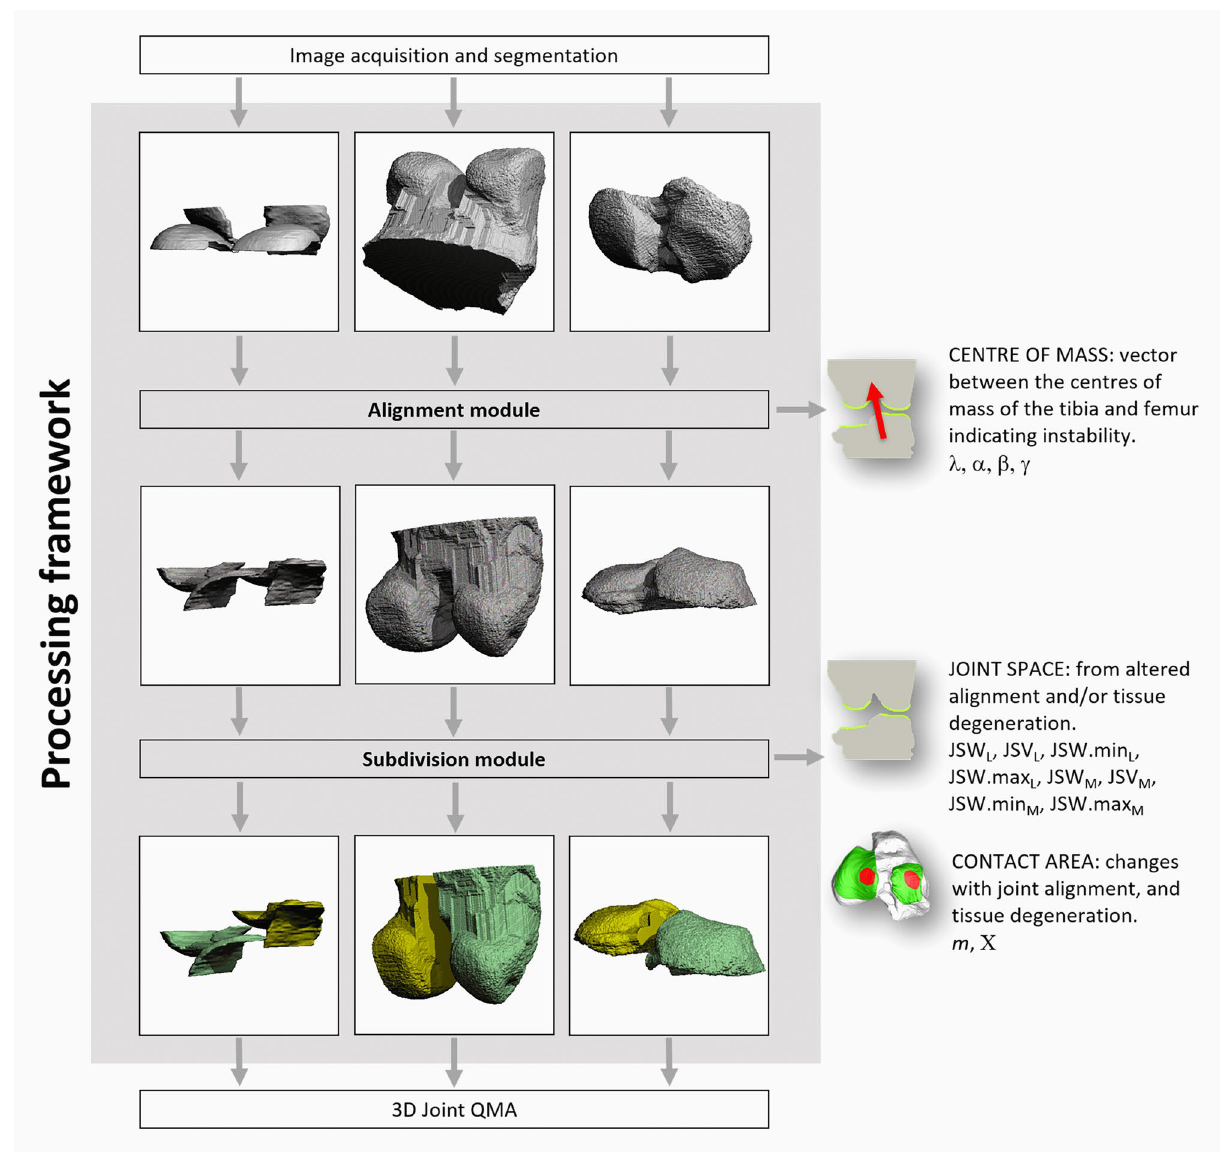
Figure 1. Overview of the pipeline as well as the relevant QMA used to evaluate each process. 3D microCT masks of cartilage (left column), femur (central column), and tibia (right column) of a typical rat knee is used to highlight each process’s input and result. Each of the outputs of the subdivision module (bottom row) is split into medial (yellow) and lateral (green) volume of